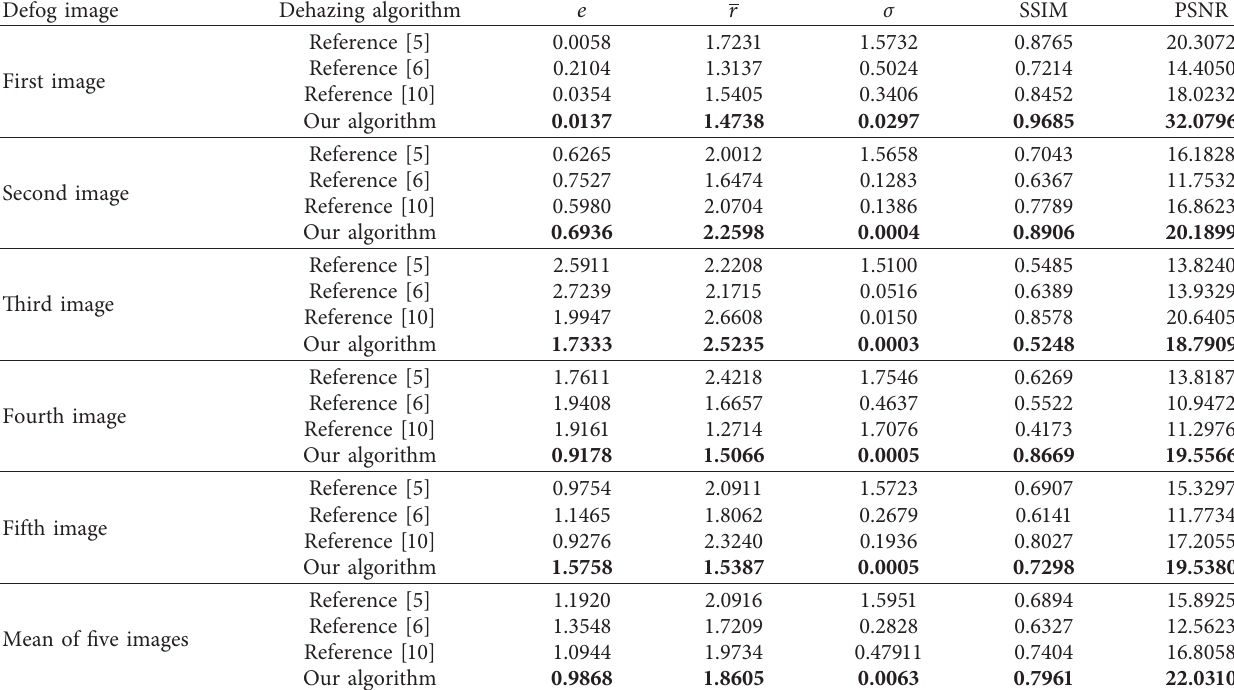
Table 3: Objective evaluation of image quality.